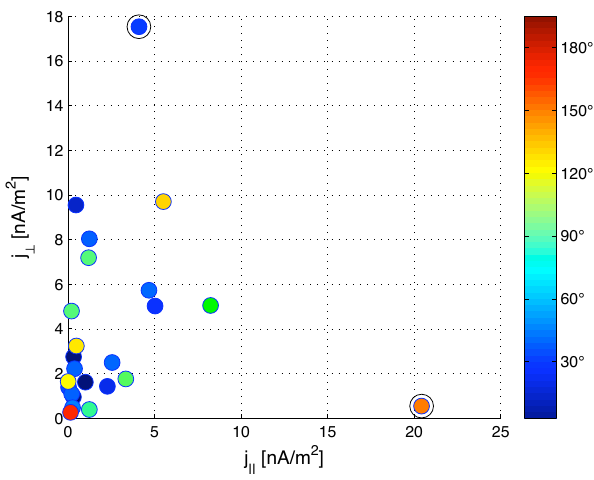
Fig. 8. Scatter plot between the estimated j ⊥ and j || , each calcu- lated at B z , min , with a color scale showing the angle α of the 24 dipolarization events. The event from 29 August 2003 is the blue dot ( α ≈ 30 ◦ ) marked by a black circle and the event from 1 October 2003 is the orange dot ( α ≈ 150 ◦ ) marked by a black